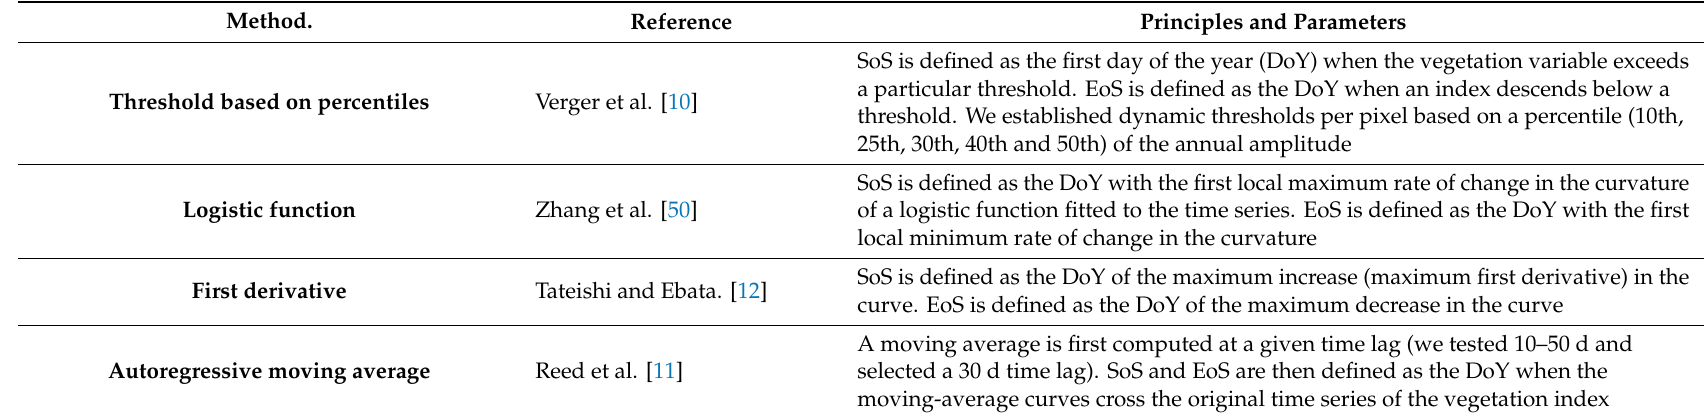
Table 1. Description of the evaluated methods for the extraction of phenology